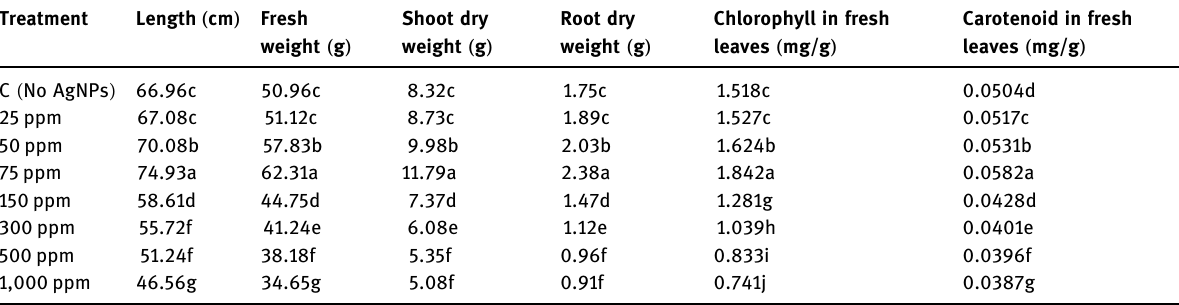
Table 1: Growth pro fi le of eggplants exposed to di ff erent concentrations of AgNPs